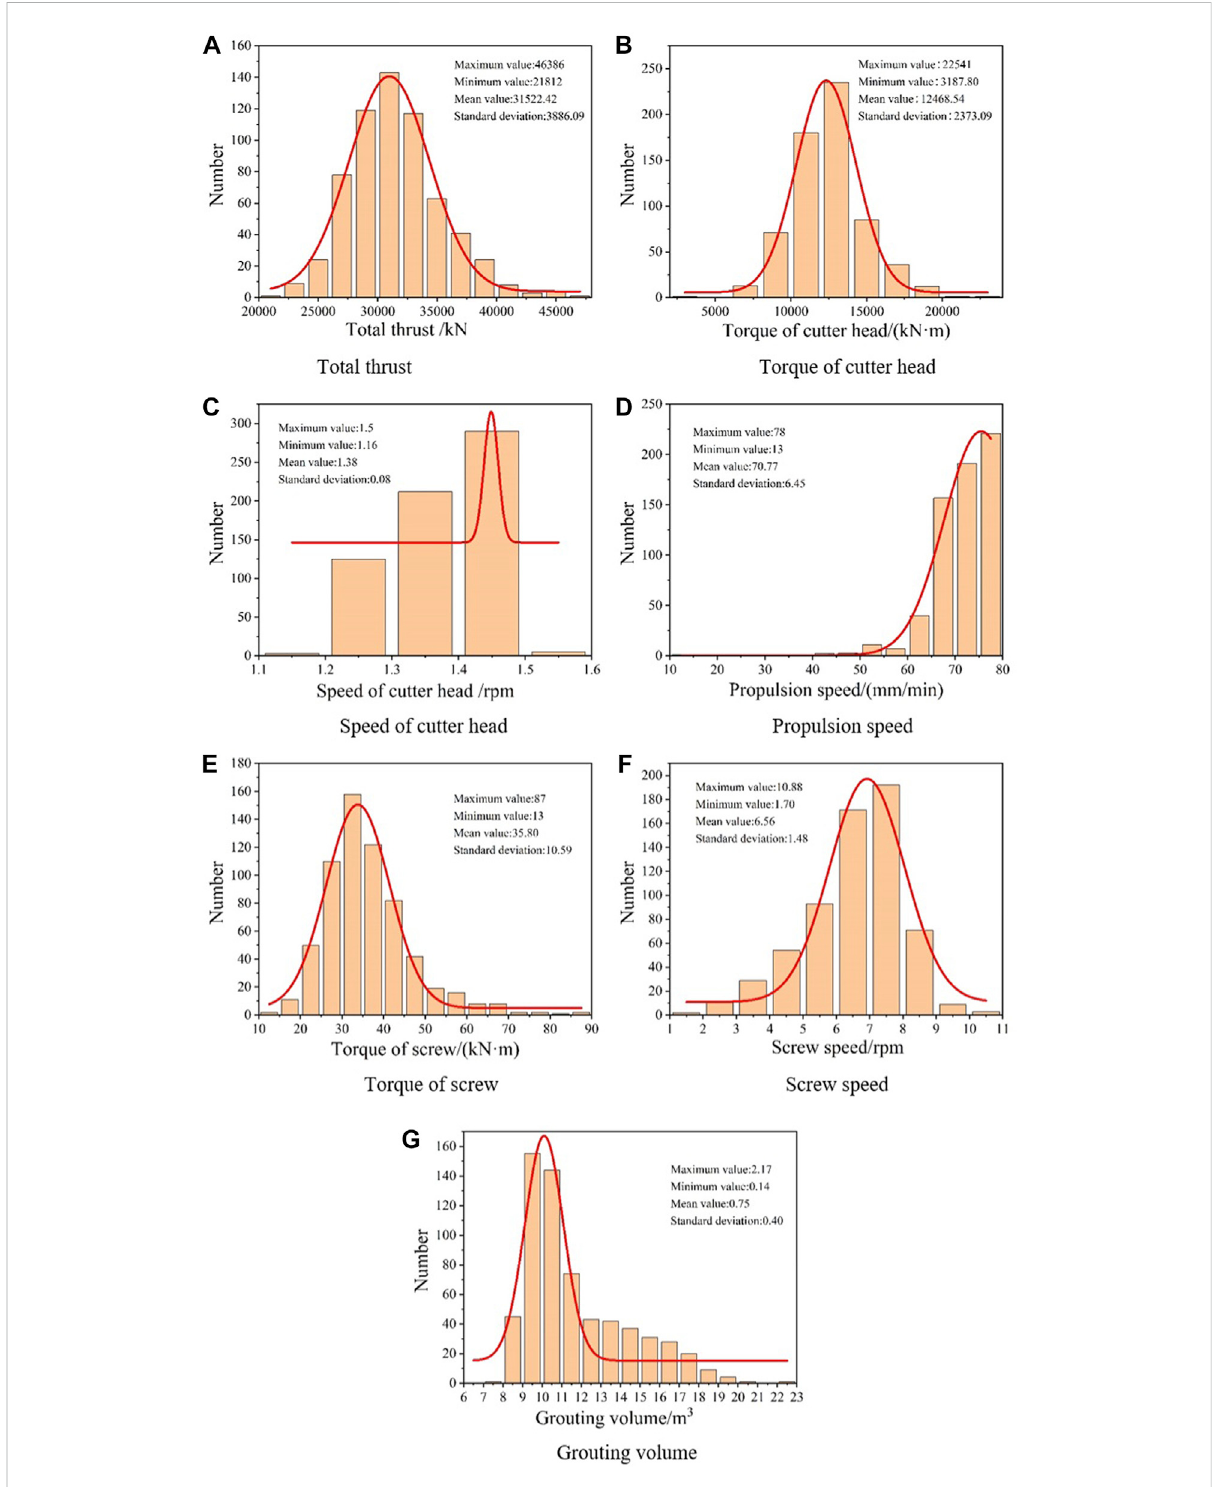
FIGURE 6 Normal distribution of shield machine